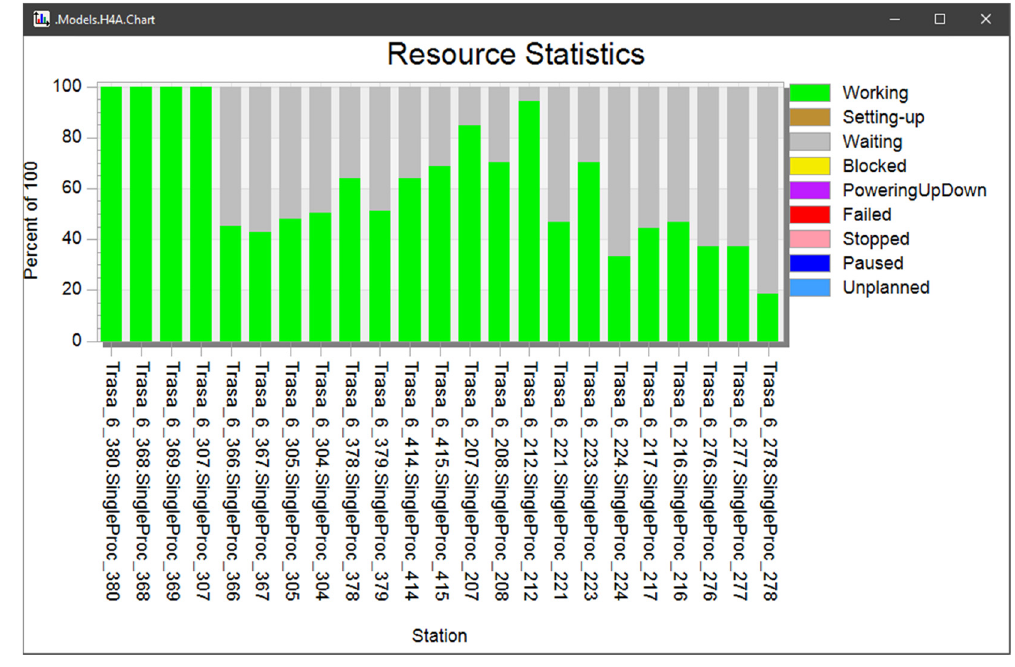
Figure 8: Histogram when supplying the line with one robotic AGV truck.